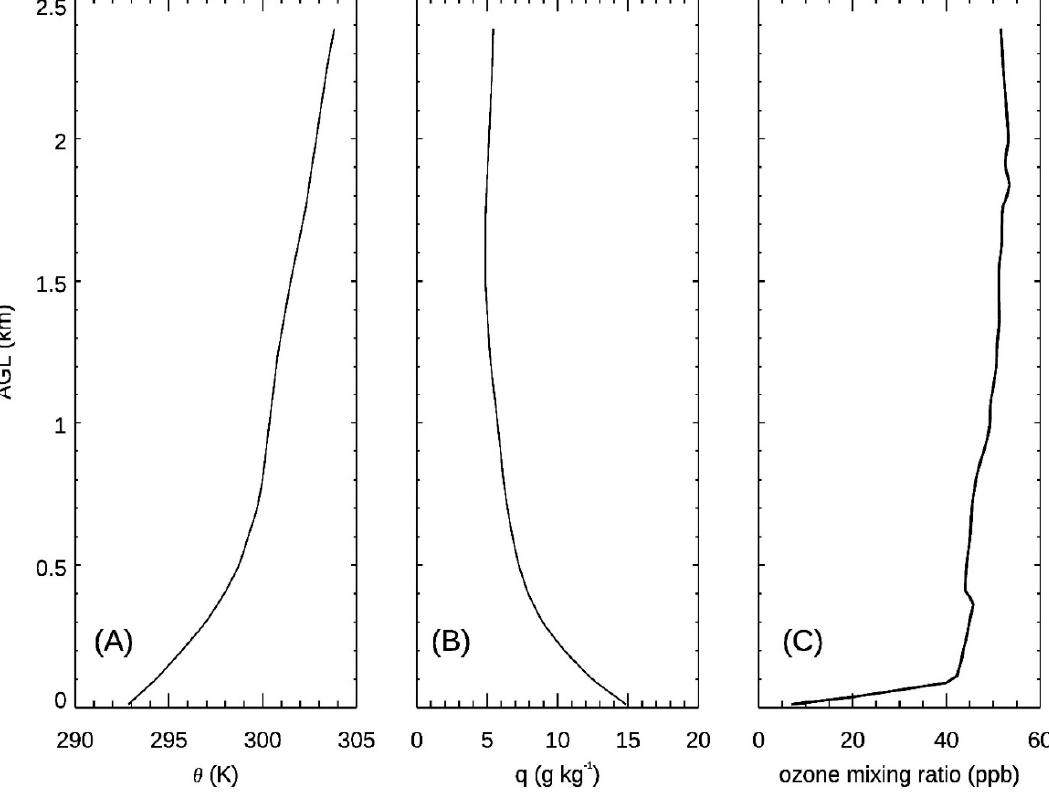
Figure 1. Initial profiles of potential temperature, water vapor, and ozone mixing ratio for DALES modeling in panels ( A ), ( B ) and ( C ), respectively. The profiles of potential temperature and water vapor were obtained from the multi-channel profiling radiometer (MPR) collocated with the RO 3 QET DIAL. The initial profile of ozone was obtained from the RO 3 QET ozone DIAL and the lowermost part was obtained from the Huntsville U.S. Environmental Protection Agency (U.S. EPA) EPA ground station 6 km away from our DIAL location.